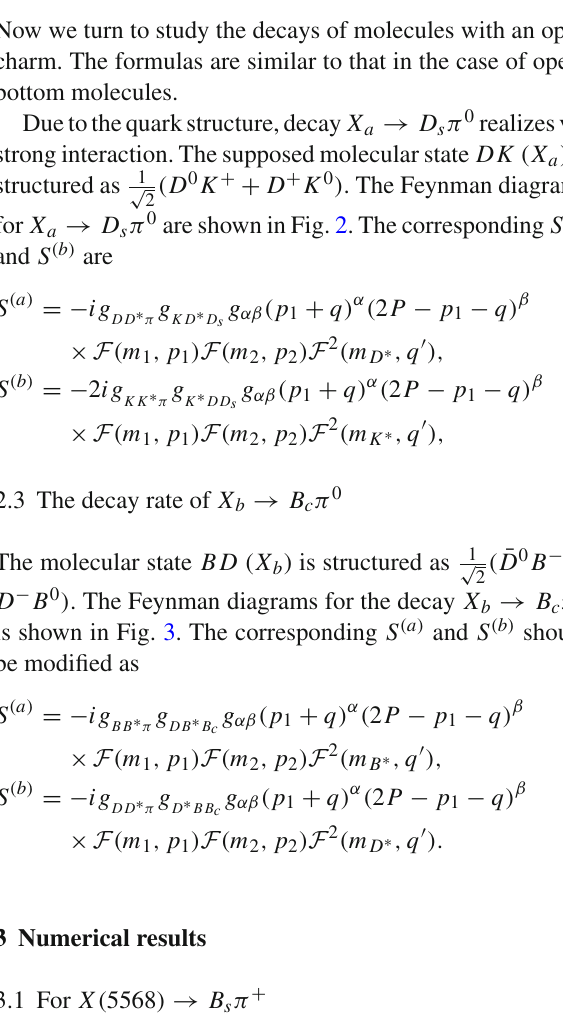
(cid:3) 2 + 2 p 1 M